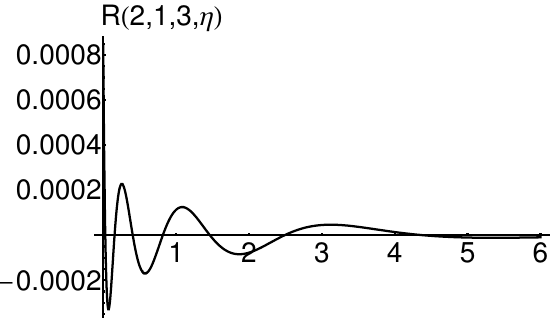
Figure 20: The residual R (2, 1, 3, η ) for Eq. (56) obtained by OAFM